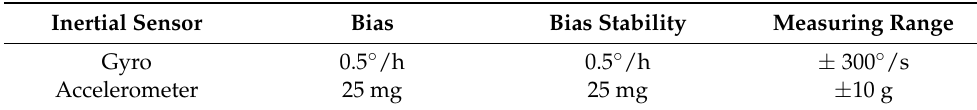
Table 2. Inertial sensor technical specifications.